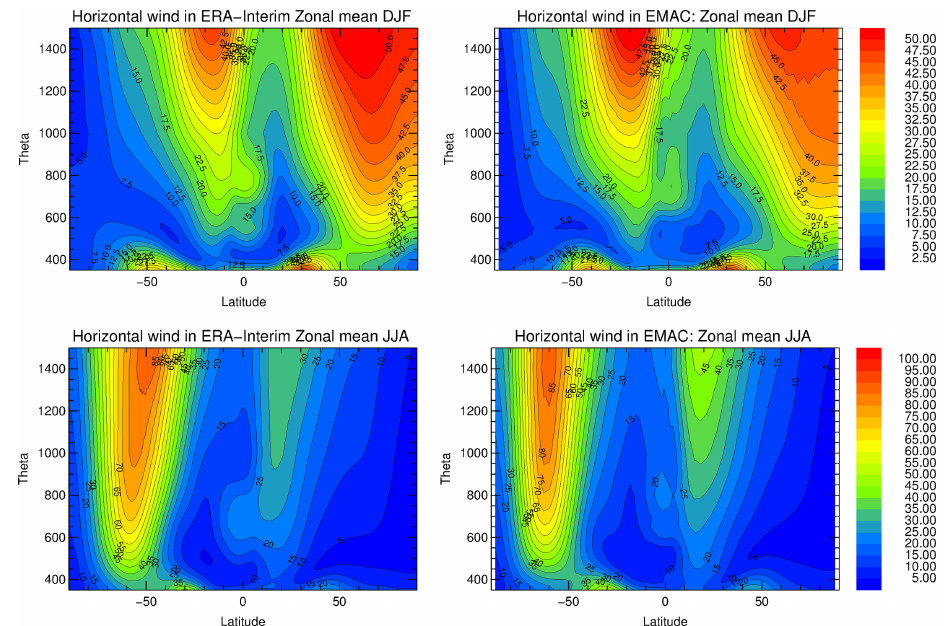
Figure 3. Zonal mean of horizontal wind speed [ms − 1 ] from ERA-Interim climatology (left column) and EMAC climatology (right column): December to February (DJF, top panels), and July to August (JJA, bottom